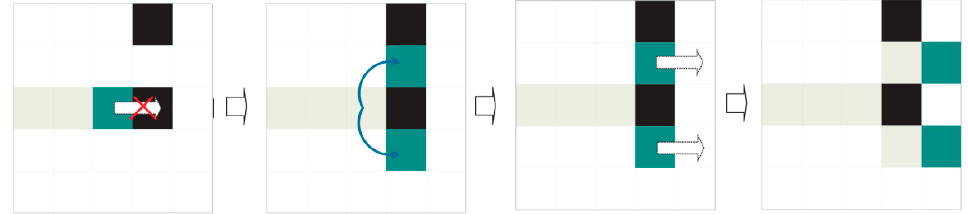
Figure 14. MITOSIS: Oblique locations are explored. Both are legal, and offspring are generated. The descendants inherit the position history of the progenitor and continue their progress. The progenitor simply disappears. Sensors 2016 , 16 , 527